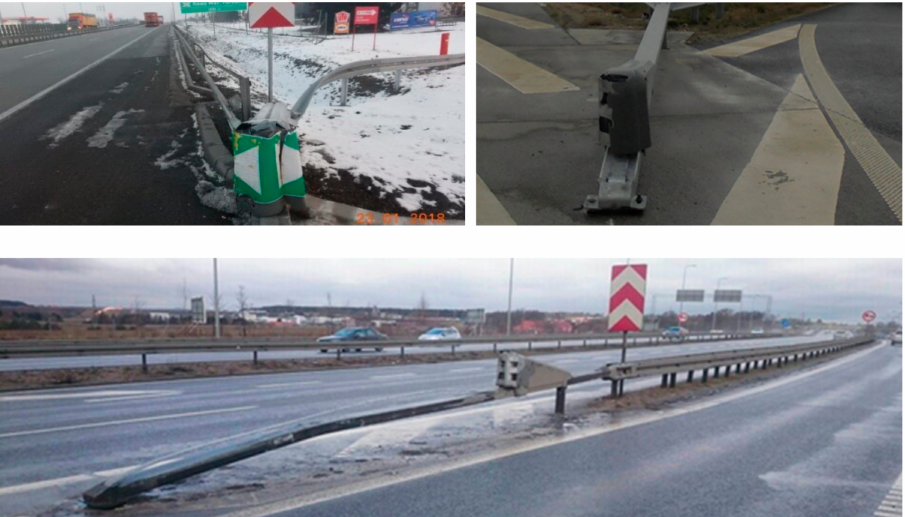
Figure 11. Condition of SE devices after vehicle collisions (source: